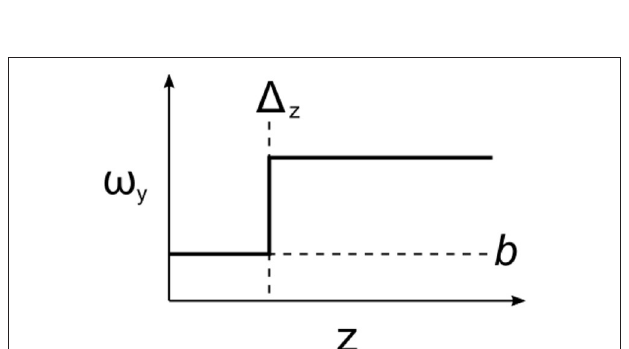
FIGURE 3 | Schematic set-up of model.